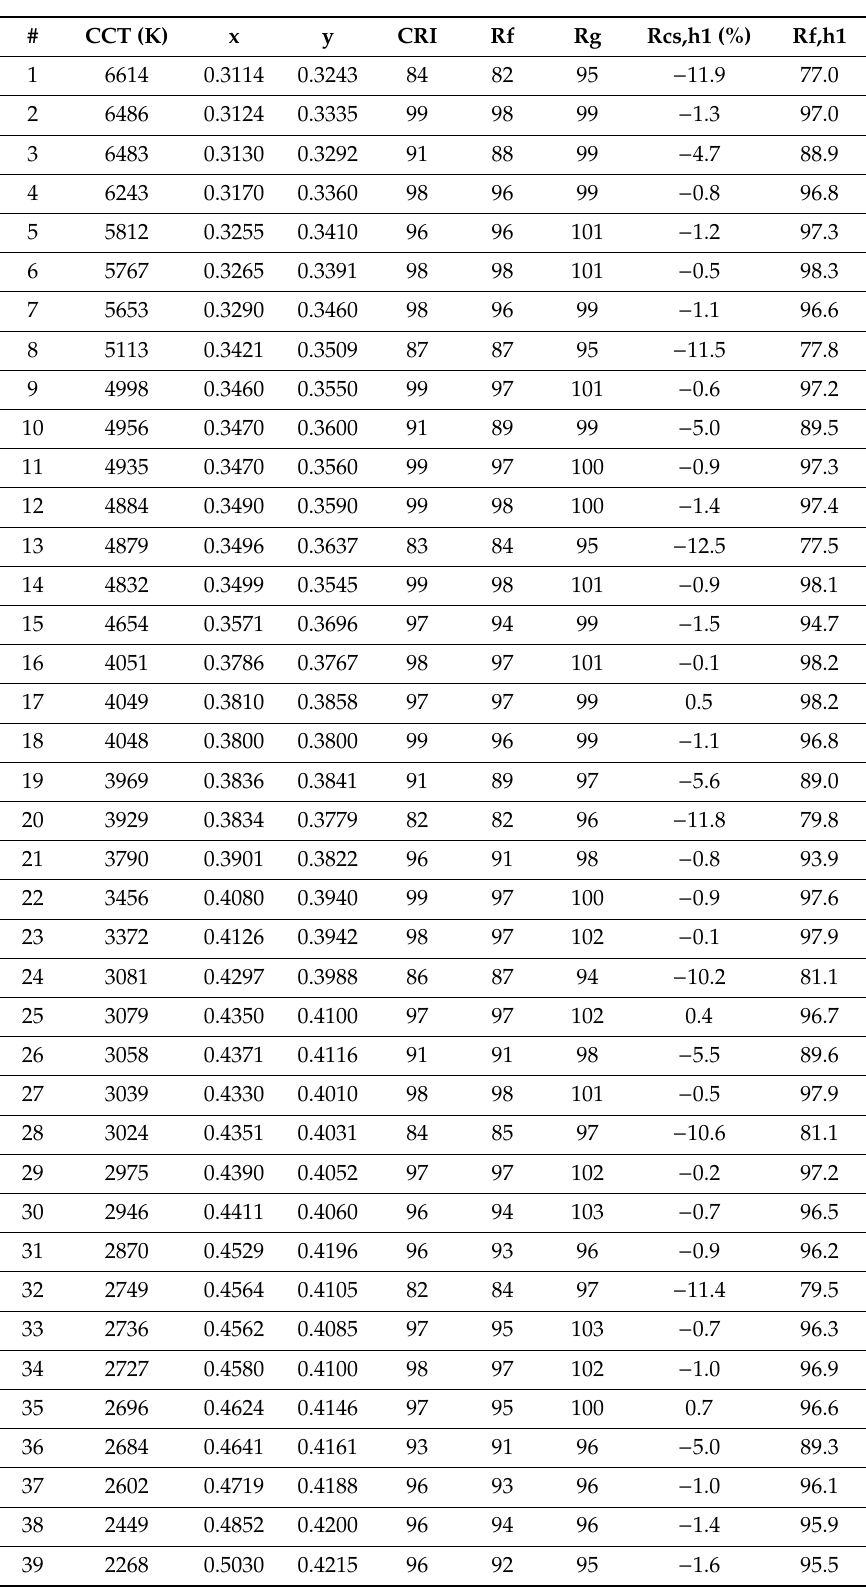
Table 1. Photometric characteristics of the LED sources. Color Rendering Index (CRI), Fidelity Index (Rf), Gamut Index (Rg), Local Chroma Shift (Rcs,h1; average relative change in chroma for colors within 1 of 16 hue angle bins (in this case j = 1)), Local Color Fidelity (Rf,h1; average similarity for color within 1 of 16 hue angle bins (in this case j =